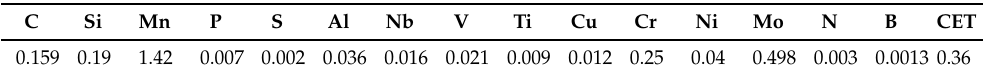
Table 1. Chemical composition of S690 Ship QT in mass percent % as specified by the manufacturer.